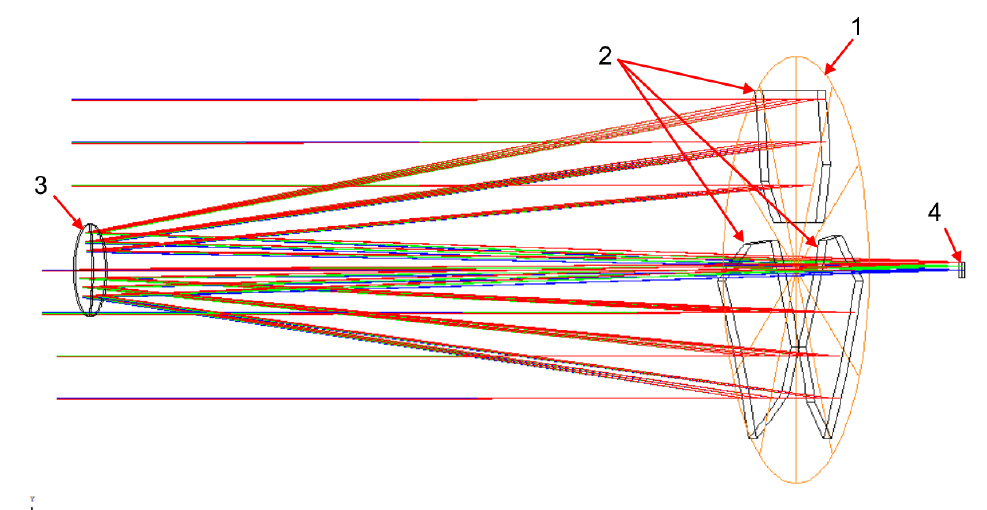
Figure 1. Optical layout of the Ritchey–Chretien type telescope with segmented primary mirror: 1—aperture stop, 2—primary mirror segments, 3—secondary mirror, 4—image